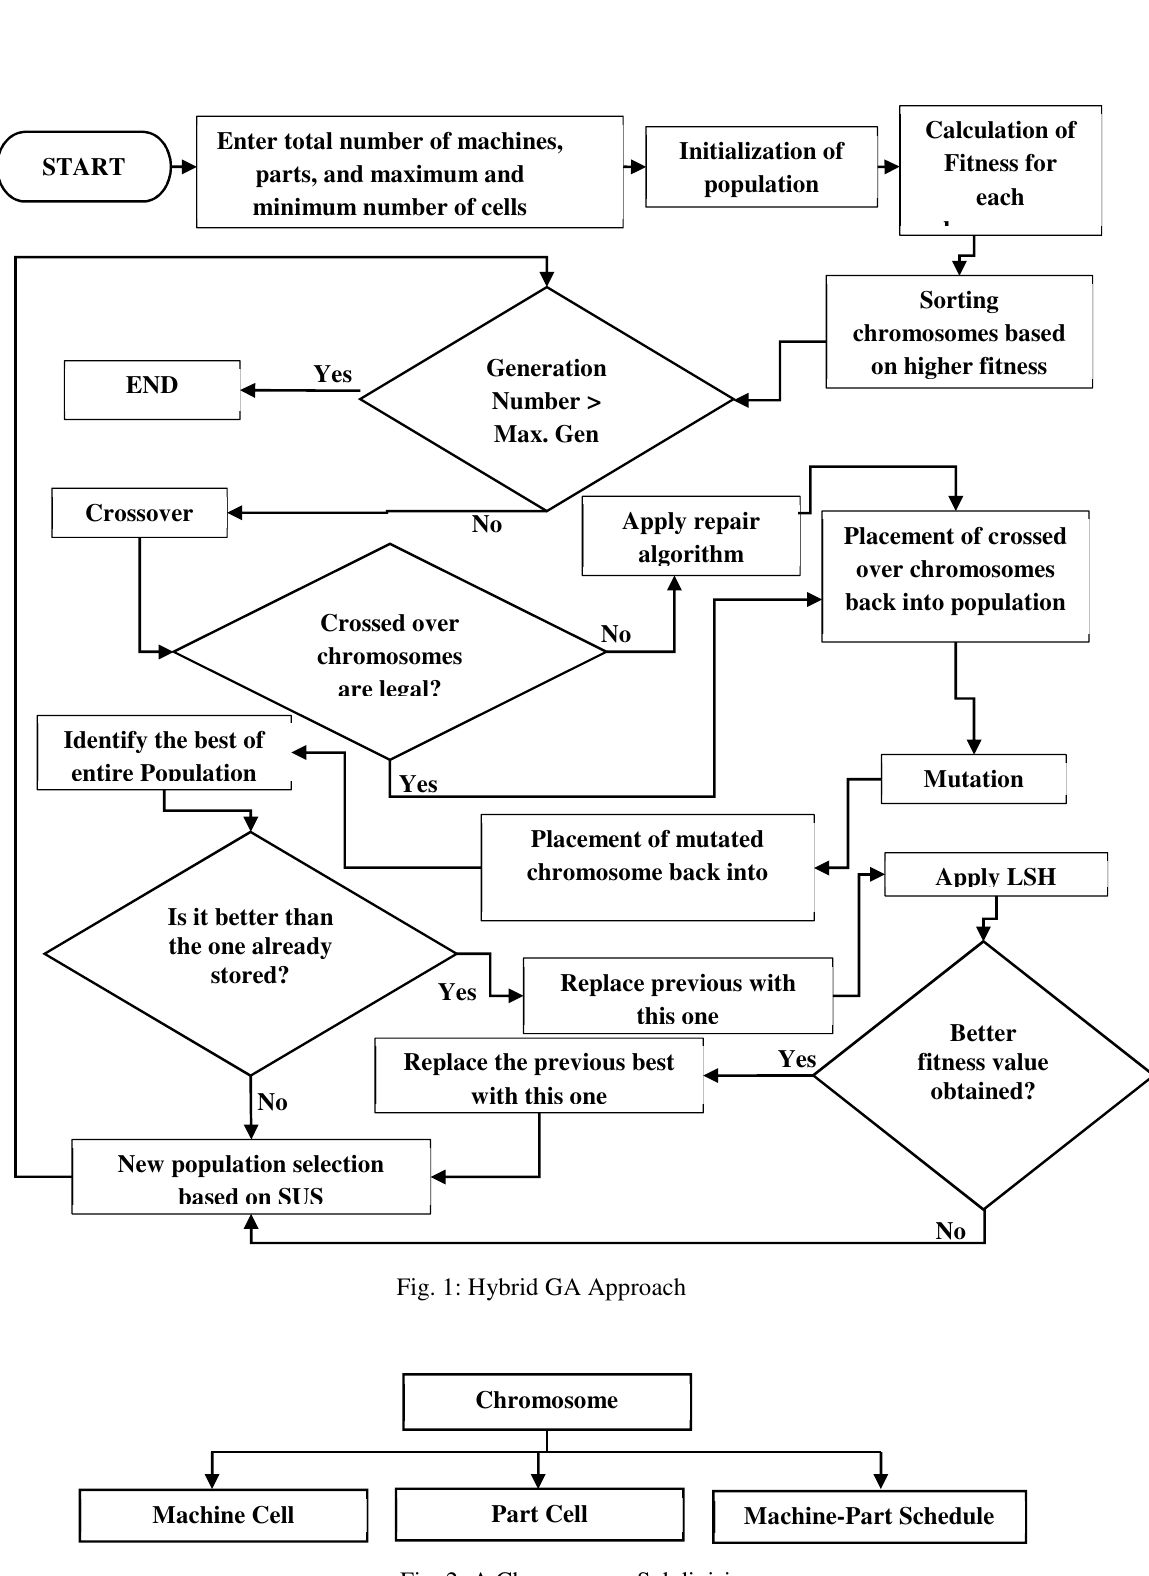
Fig. 2: A Chromosome